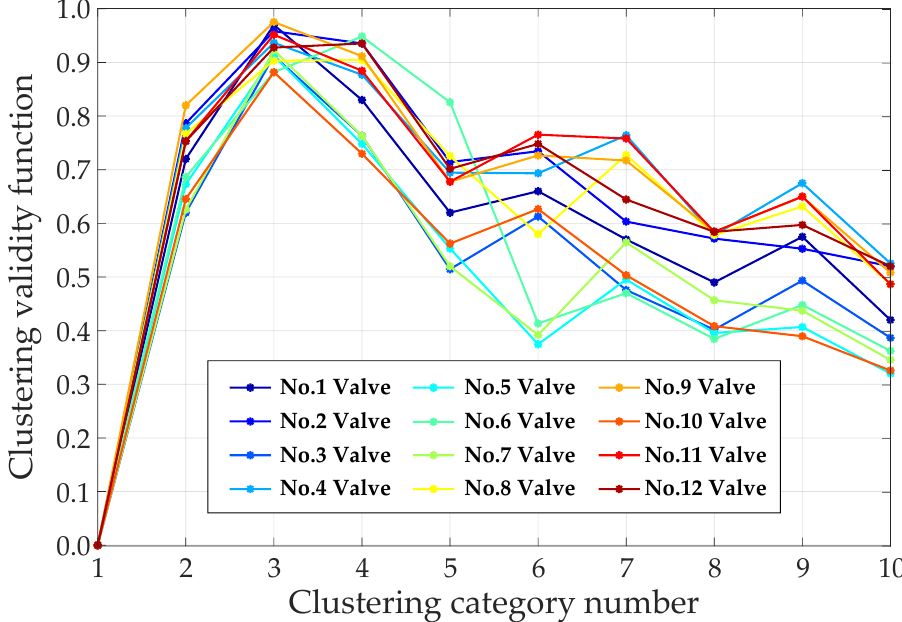
Figure 9. Clustering validity for different category numbers.